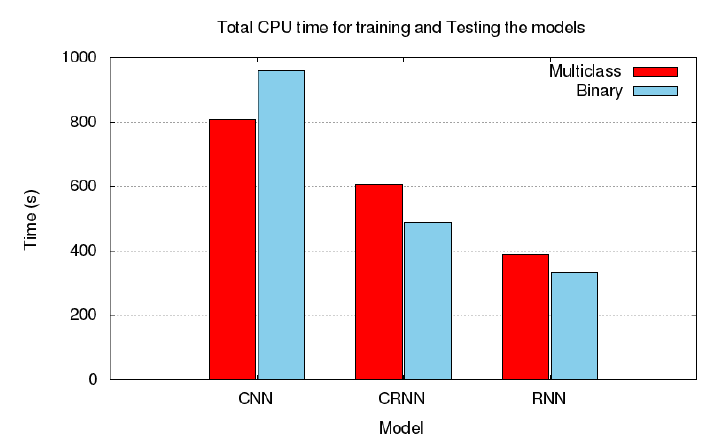
Figure 7. CPU time Results [38].